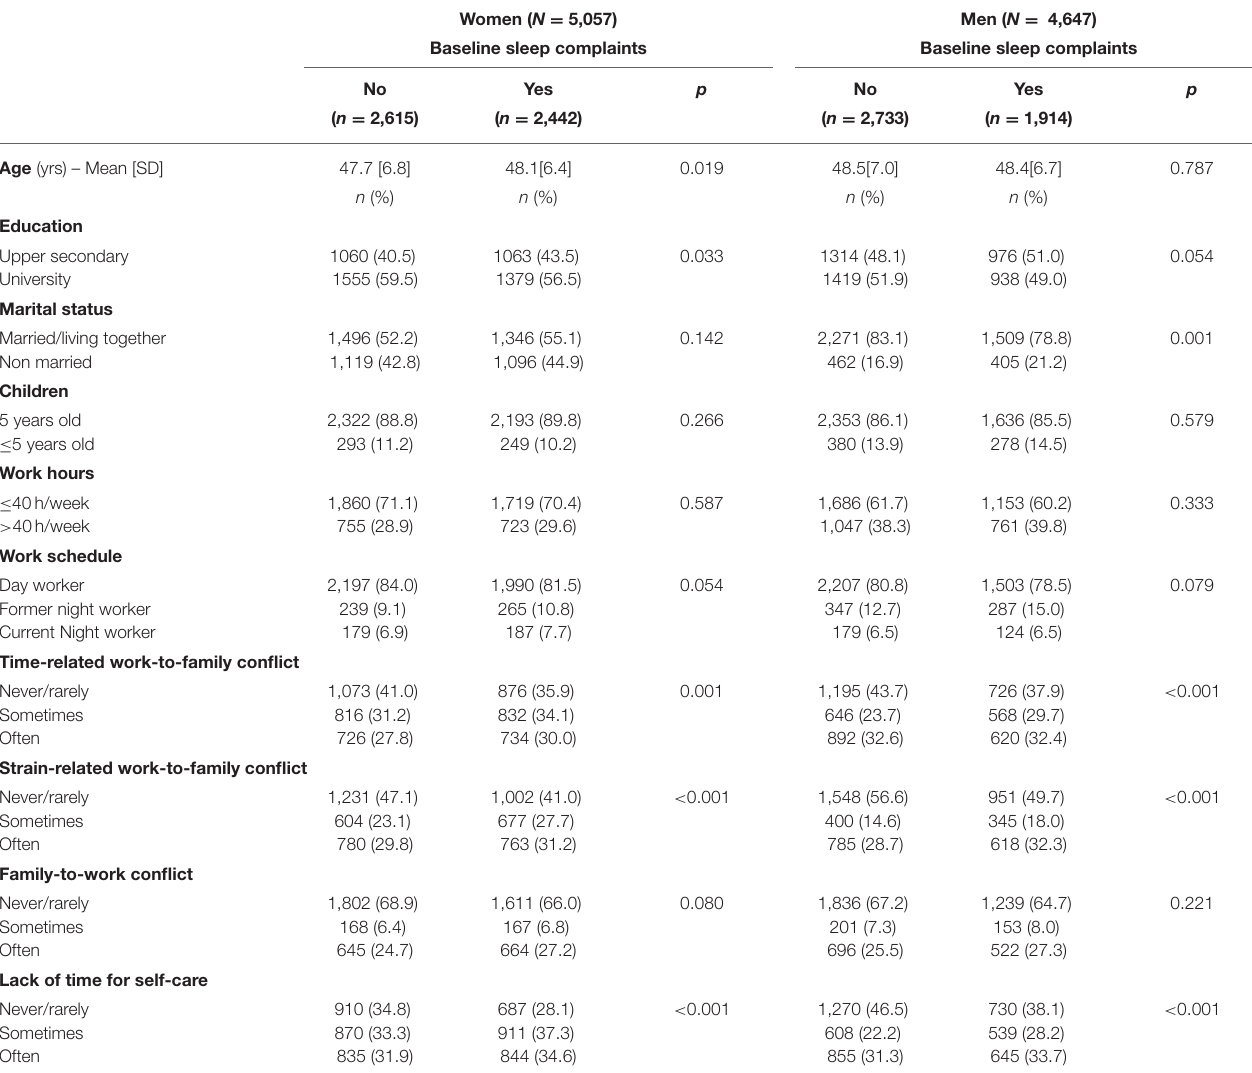
TABLE 1 | Baseline characteristics of the study population according to baseline sleep